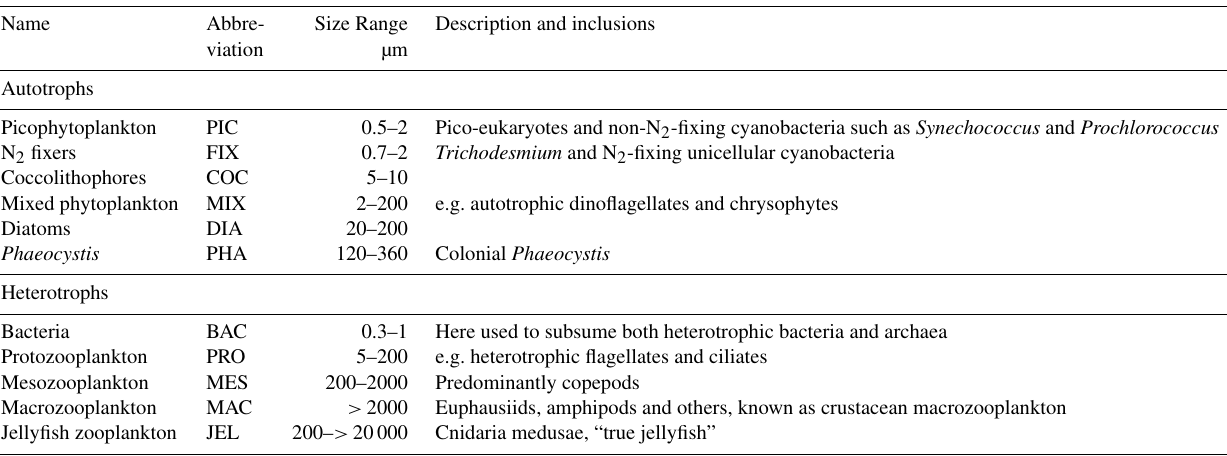
Table 1. Size range and descriptions of PFT groups used in PlankTOM11. Adapted from Le Quéré et al.